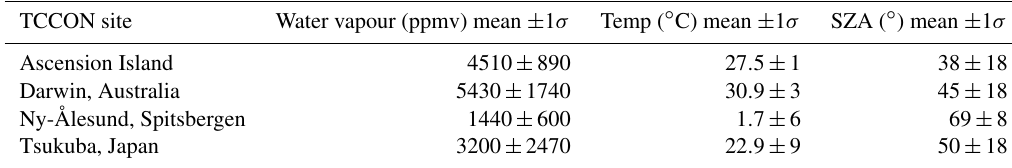
Table 2. TCCON site water vapour, temperature, and SZA average and variation. TCCON